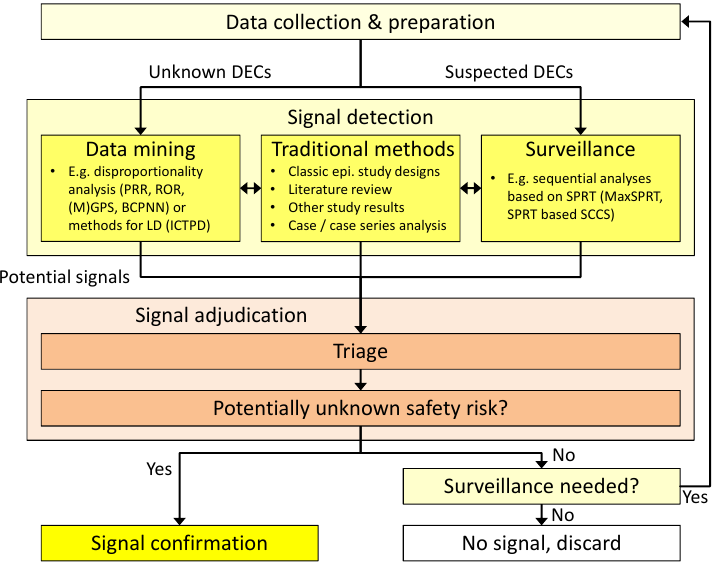
Figure 1. Schematic overview of the signal detection process (based on a figure from [2] in [3]) (DEC = drug-event-combination, PRR = proportional reporting rate, ROR = reporting odds ratio, MGPS = Multi-item Gamma-Poisson Shrinker, BCPNN = Bayesian confidence propagation neural network, LD = longitudinal data, ICTPD = information component temporal pattern discovery, SPRT = sequential probability ratio test, SCCS = self-controlled case